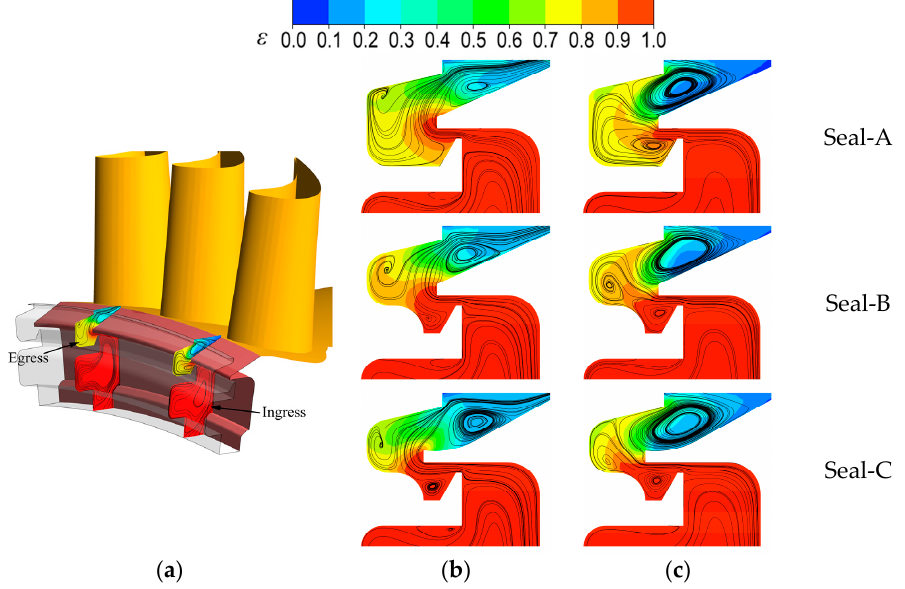
Figure 23. Time-averaged sealing efficiency contour distributions and surface streamlines at the sections of ingress and egress for IF = 0.6%: ( a ) position of the disk cavity sections; ( b ) egress section; ( c ) ingress section.